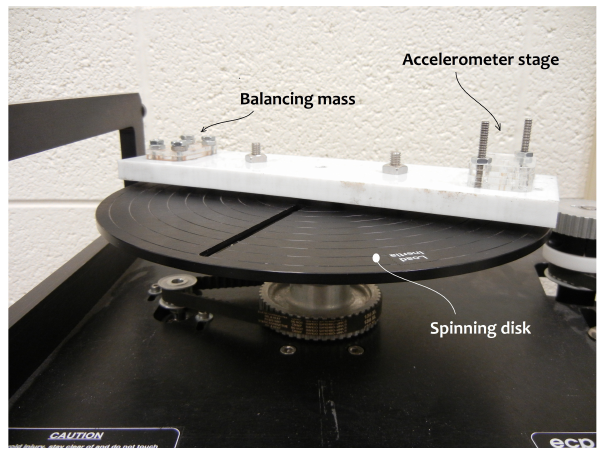
Figure 7. Disk and accelerometer stage used to test switching